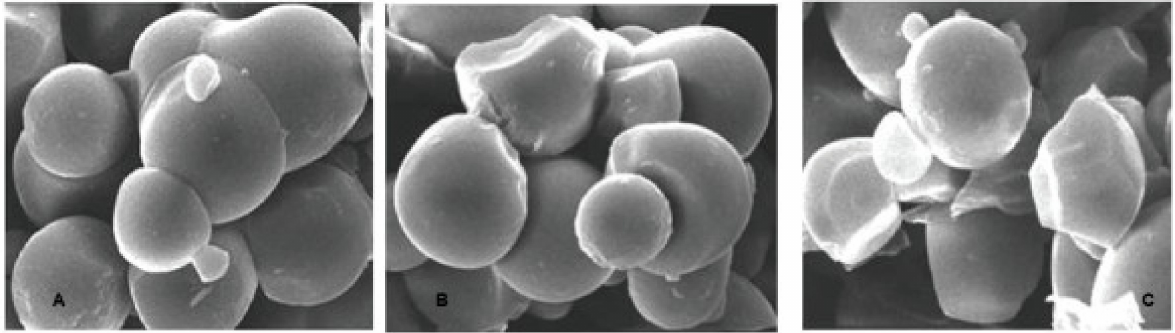
Figure 3. SEM microphotographs of cassava flour: ( A ) Native (unfermented); ( B ) Modified; ( C ) Fermented. Source: [62]. With the aid of High-Resolution Optical Microscopy, micrographs of CF can be ob- tained (Figure 4). Through an optical microscope coupled with a digital camera and application of toluidine blue dye on samples, fibers and starch granules were distinctly captured [39]. In the micrographs, it was observed that the number of starch granules was greater than the number of fibers in